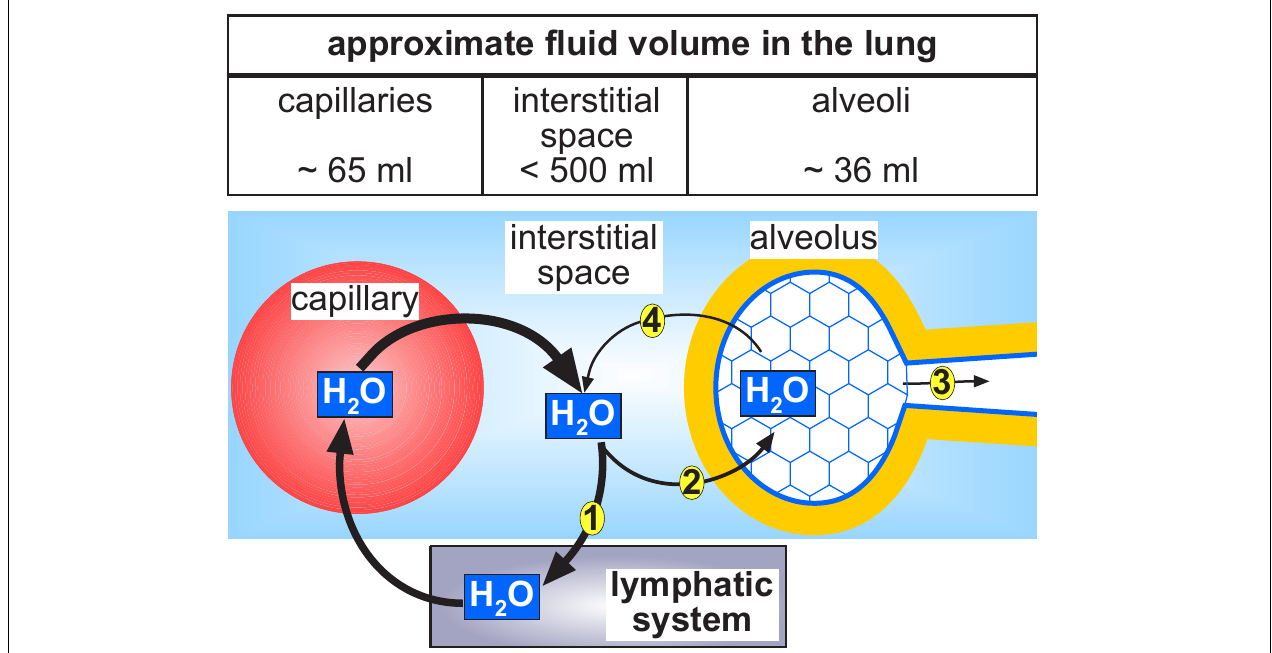
interstitial space enters the alveoli (2). From the fluid inside the alveoli one part evaporates and is exhaled during respiration (3). In order to balance the fluid content in the alveoli, another part of the alveolar fluid is reabsorbed (4) by the activity of the alveolar epithelial cells back to the interstitial space from where it can be drained (1) back to the vascular